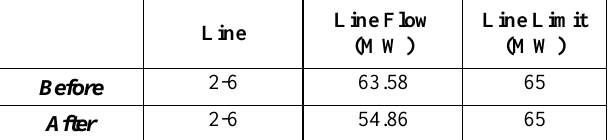
Table 9.Power flow in some critical lines before and after rescheduling (Case 2)